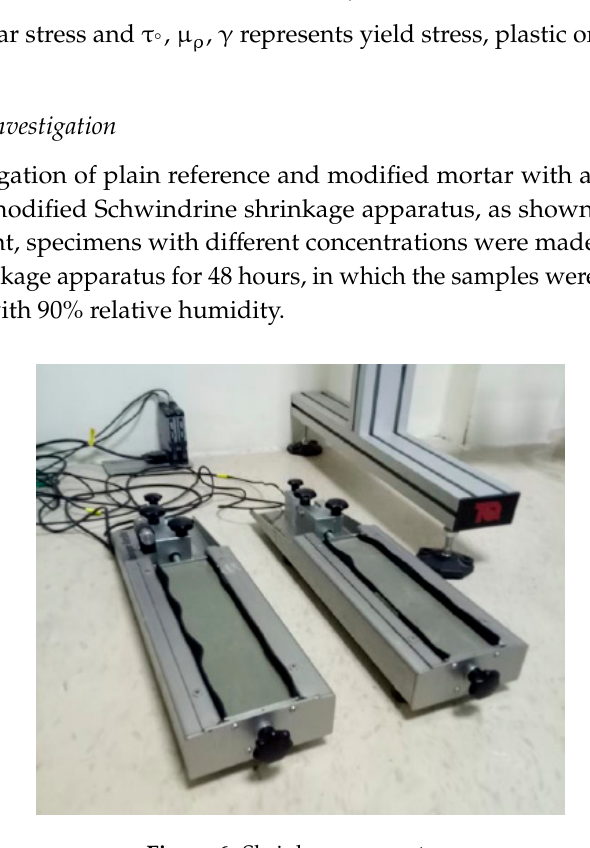
Figure 6. Shrinkage apparatus